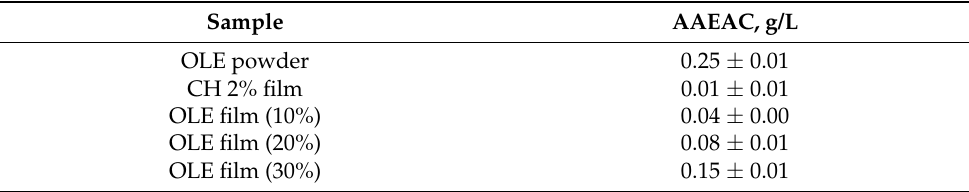
Table 1. Antioxidant activity expressed in ascorbic acid eq. (g L − 1 ). Average ± standard